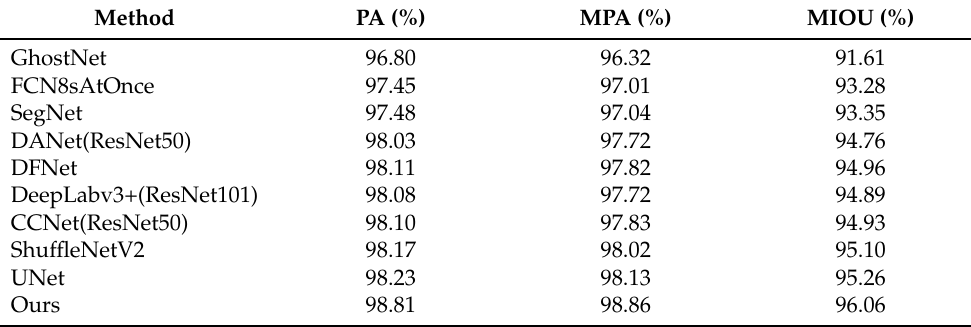
Figure 9. Comparison of different models on on the water segmentation datasets. ( a ) Real image; ( b ) label; ( c ) FCN8s; ( d ) SegNet; ( e ) DFNet; ( f ) DeepLabV3+; ( g ) ShuffleNetV2; ( h ) UNet; ( i ) our segmention results. Table 2. Comparison of evaluation indexes of different models on the water segmentation